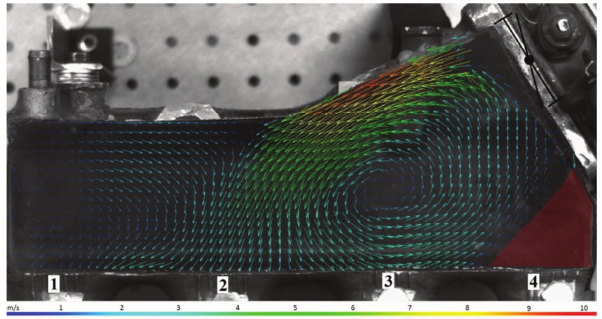
Fig. 8. Velocity vector distribution and air flow direction in the intake manifold at 1500 RPM engine speed and 10˚ throttle position angle